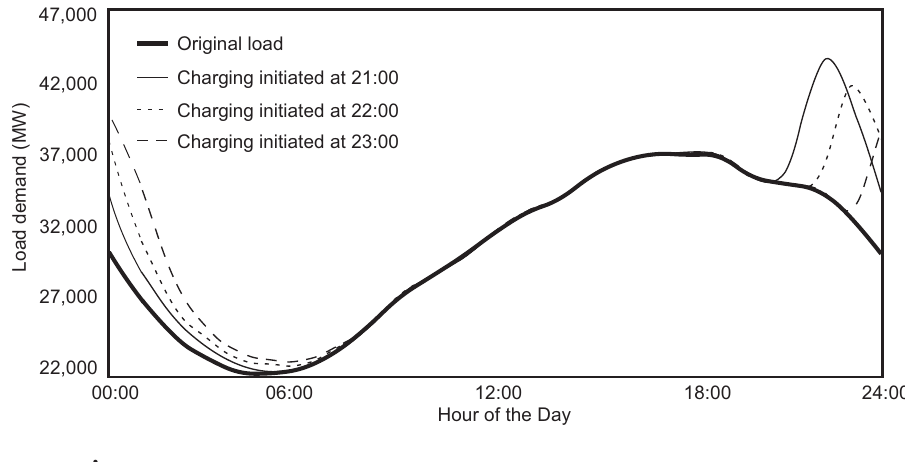
Figure 5. Residential load as a function of charger